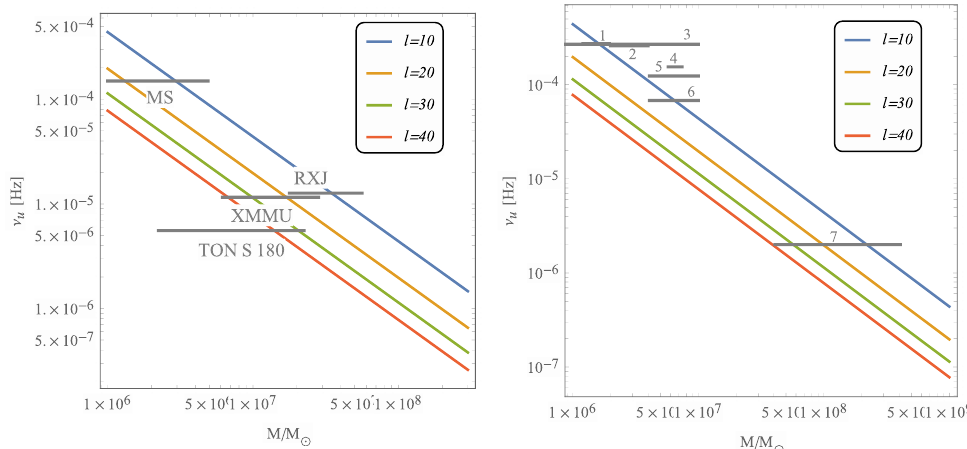
Figure 11. Fit of 3:2 frequencies ratio to mass estimate of assumed supermassive black holes in active galactic nuclei for various values of the parameter l giving wormholes. Sources with unknown rotation estimates are marked in the left panel. On the right panel are sources with a known estimate of spin listed in Table 1 (cf.